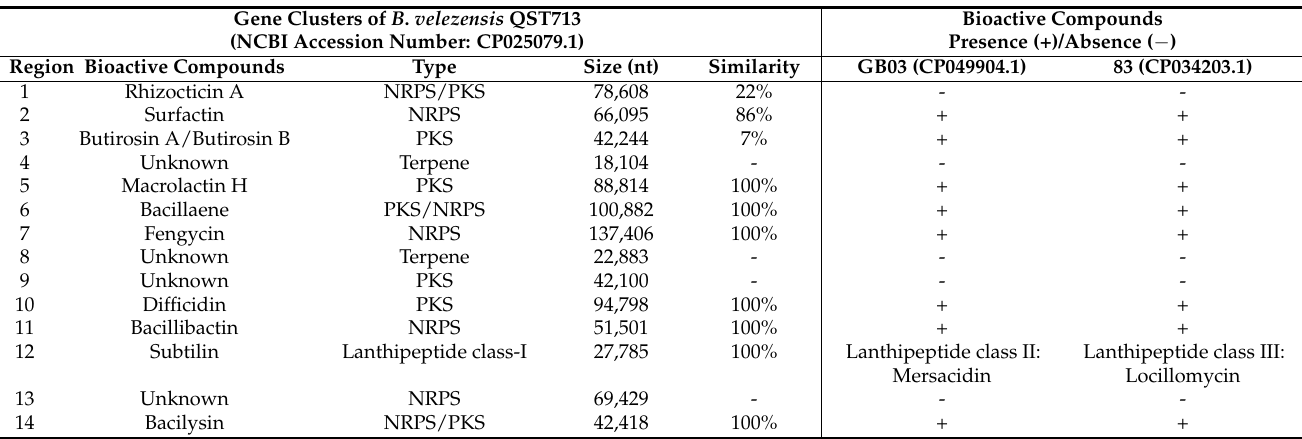
Table 1. Comparison of gene clusters encoding antimicrobial compounds in several commercial B. velezensis- based biocontrol agents. The gene clusters in B. velezensis QST71 (Serenade ® ) are compared with the genomes of B. velezensis GB03 (Kodiak TM) and B. velezensis 83 (Fungifree AB™).